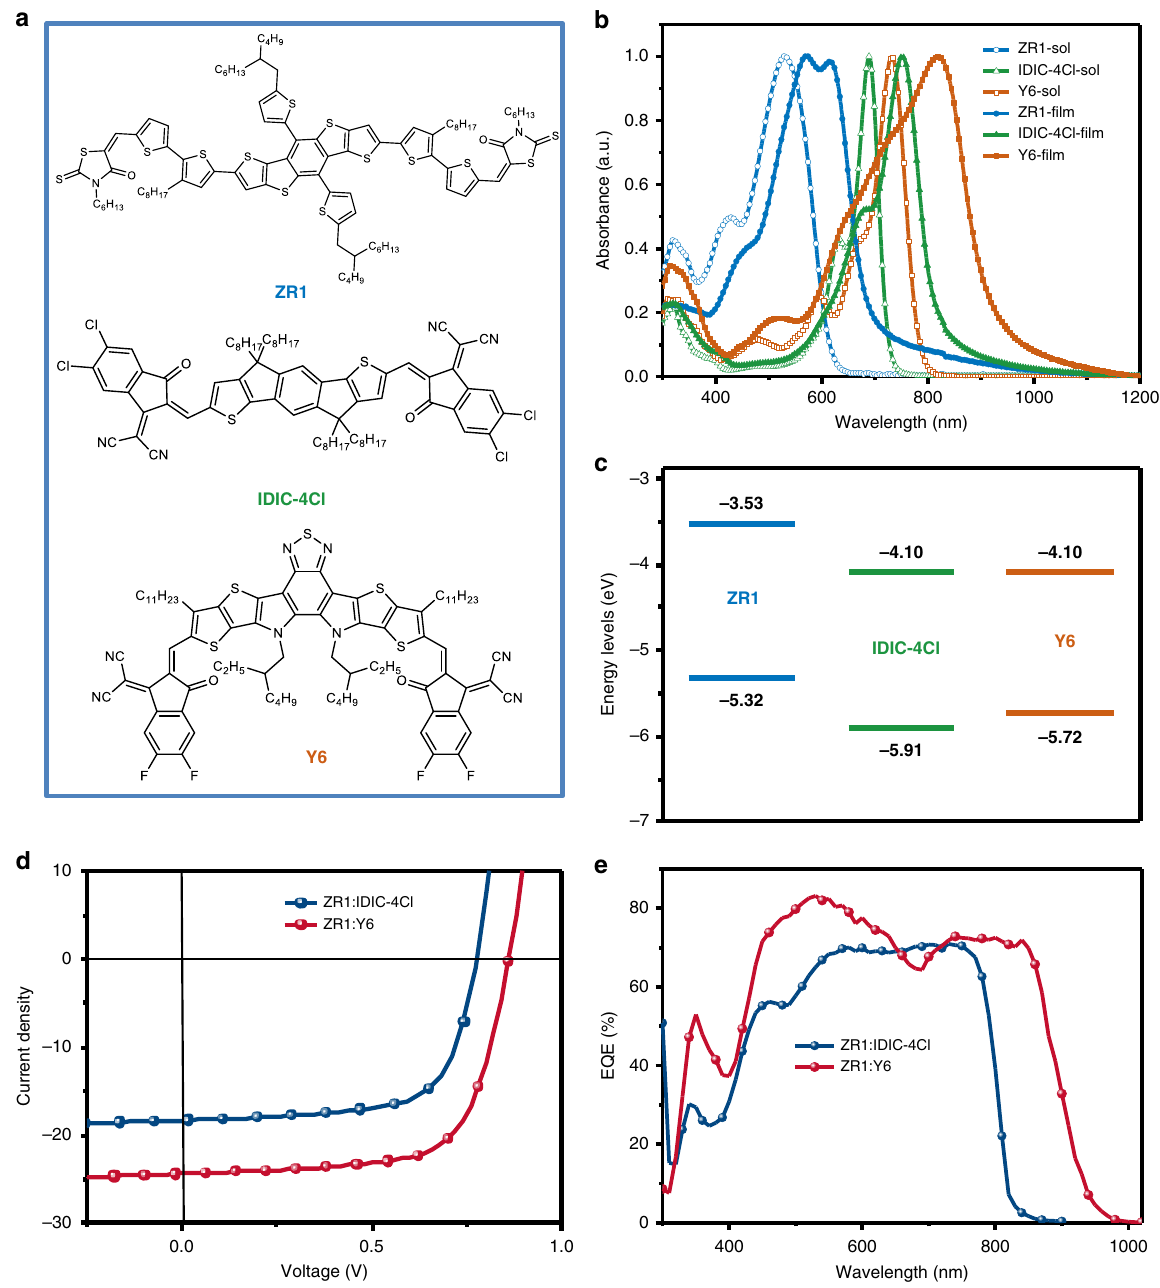
Fig. 1 Molecular structures, properties and photovoltaic performance. a ZR1, Y6, IDIC-4Cl molecular structures. b Normalized UV – vis absorption spectra of ZR1, Y6, IDIC-4Cl in solution and thin fi lms. c Energy diagrams of ZR1, Y6, IDIC-4Cl. d Optimized J – V curves for conventional devices. e EQE corresponding to devices in d